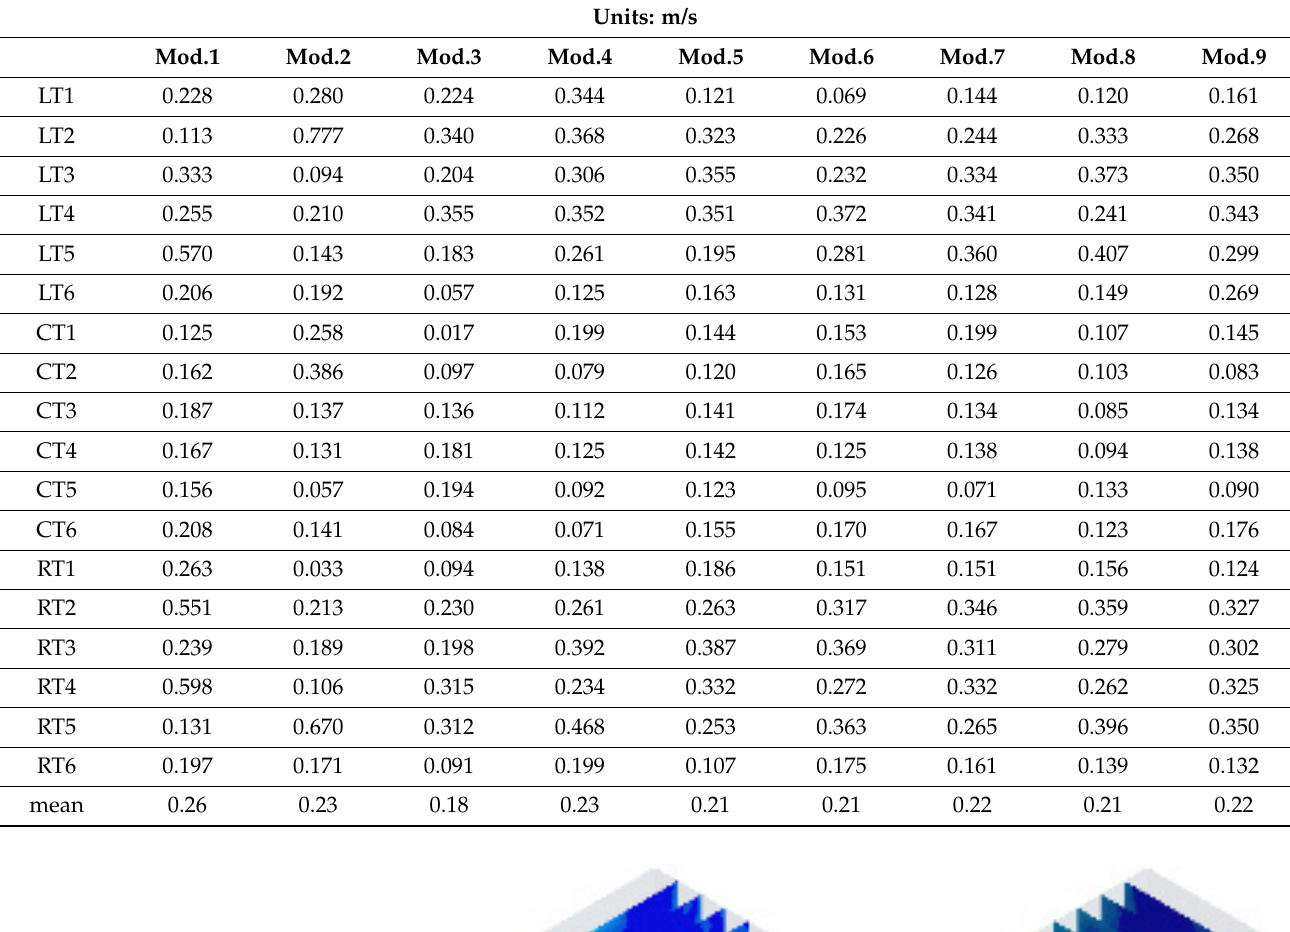
Table 4. Air flow velocity at the upper 18 points. Units: m/s